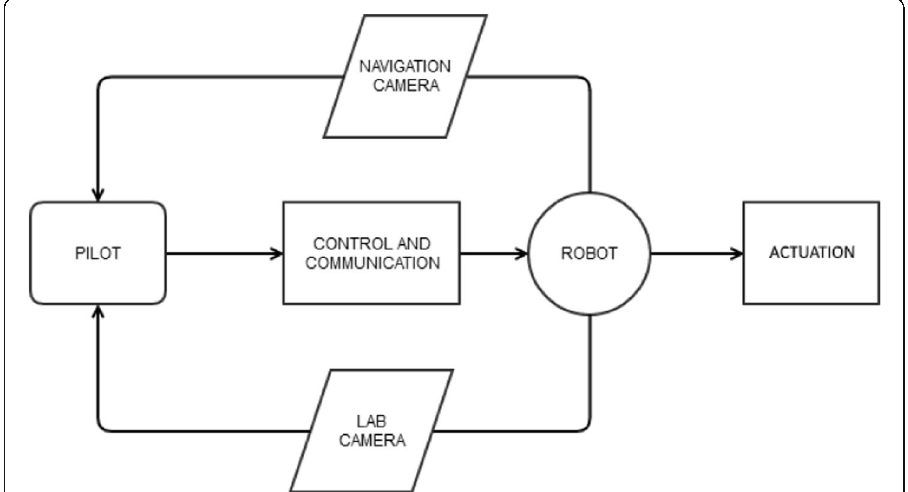
Fig. 5 The closed-loop control for the telepresence